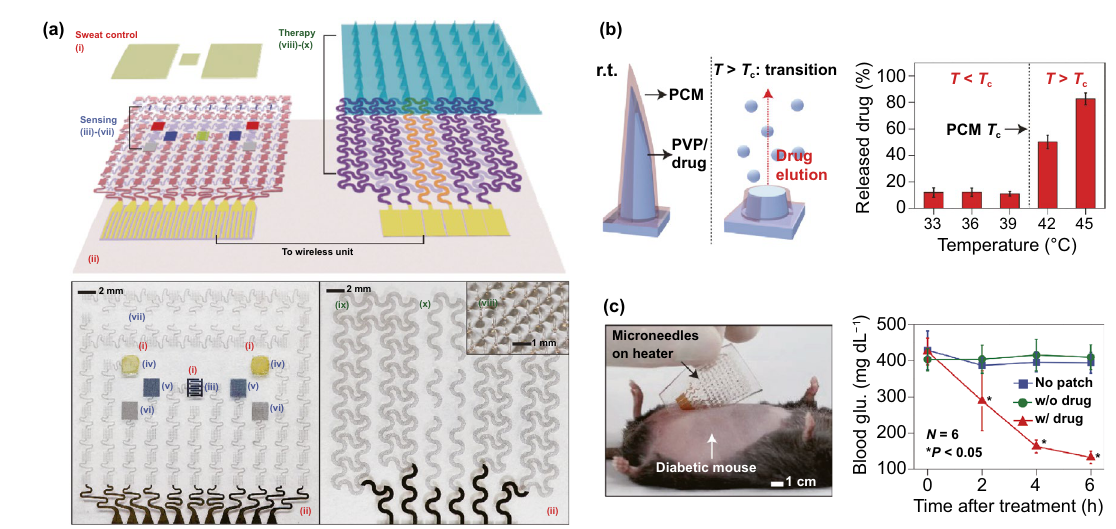
Fig. 12 Integrated diagnosis & treatment system using microneedles for controlled drug delivery. a Schematics and corresponding photographs of the stretchable skin‑mounted closed‑loop diabetes monitoring and therapy device, including the sweat glucose‑sensing module (left) and elec‑ tro‑thermal triggered therapeutic microneedle patch (right), with GP‑hybrid materials widely used. The controlled release mechanism of thermal responsive microneedles (left) and its temperature dependence were illustrated in b . c By delivering metformin to diabetic mice in vivo, this microneedles treatment presented significant blood glucose suppression [231]. Reproduced with permission from Ref. [231], copyright (2016) Nature Publishing